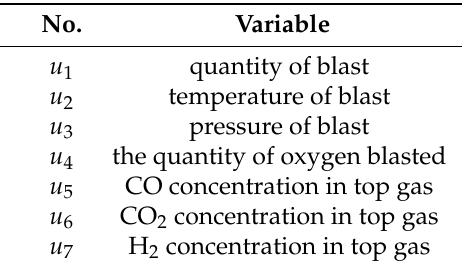
Table 1. The input variables for Case